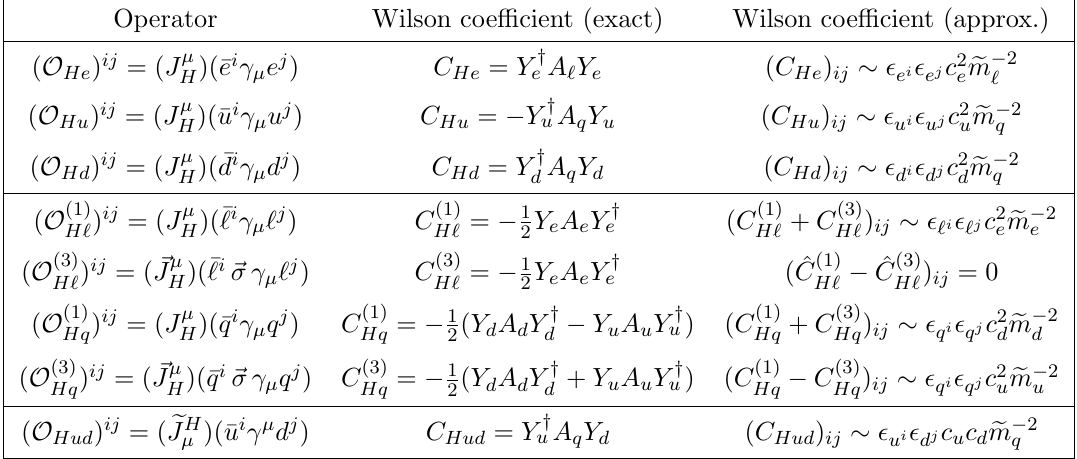
Table 4. Current-current operators and their Wilson coe(cid:14)cients.